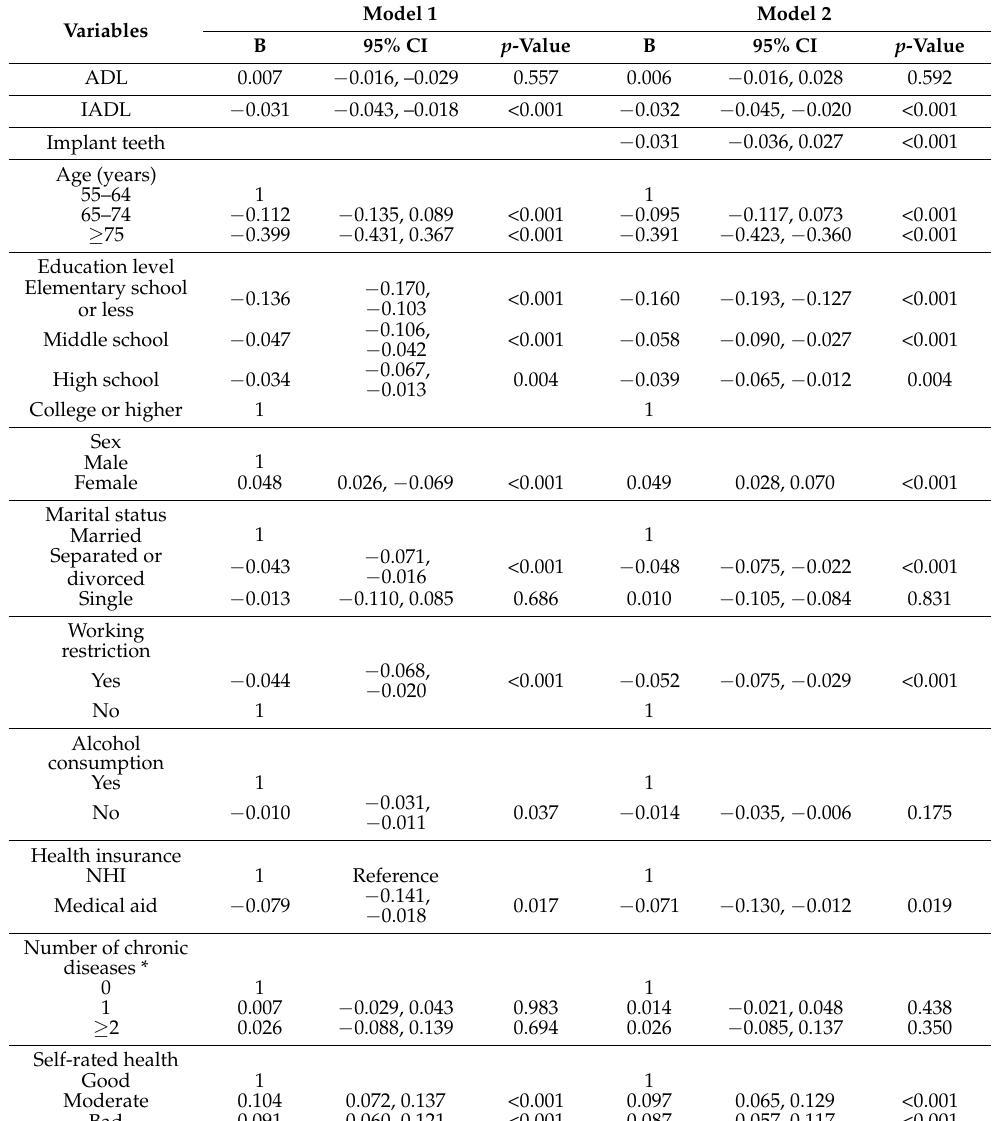
Table 2. Association between ADL/IADL and natural